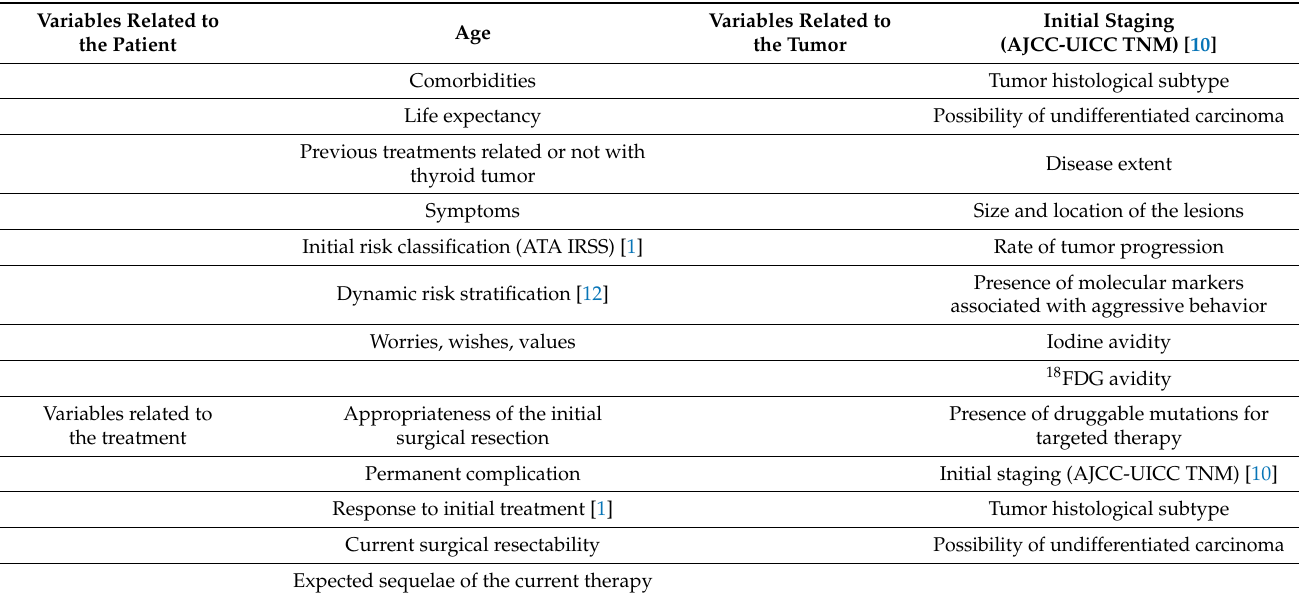
Table 1. Variables under initial concern to guide the basis of therapeutic decision making for patients with locoregional persistent or recurrent WDTC following initial